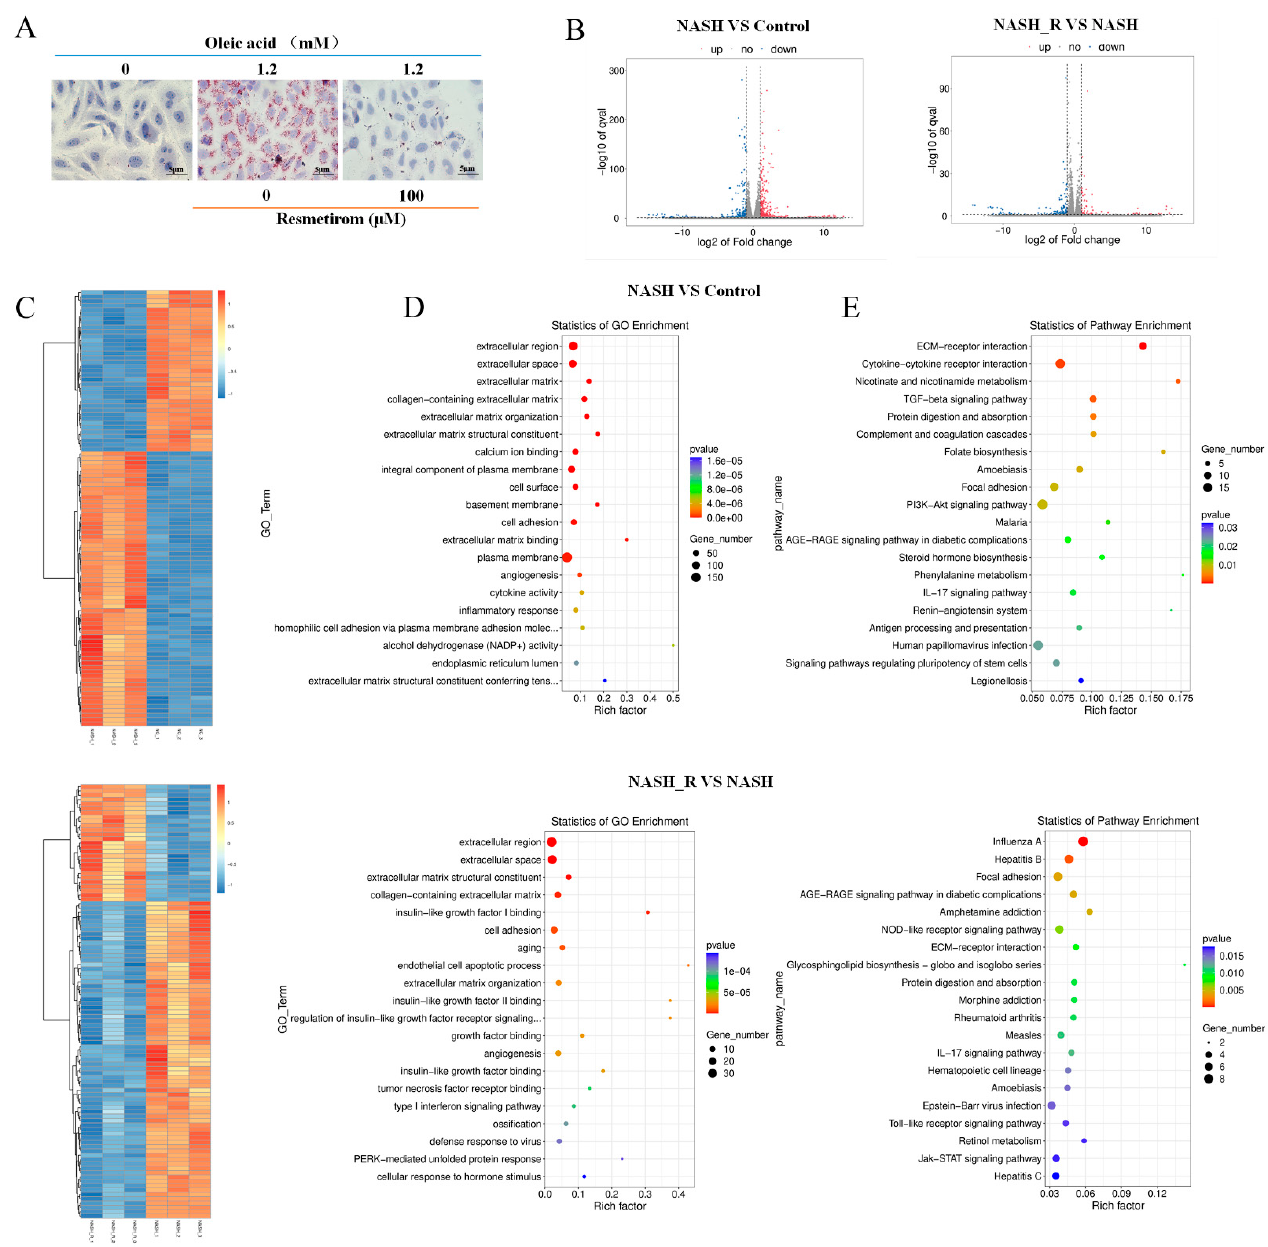
Figure 2. mRNA sequencing was performed to elucidate the mRNA expression profile in the resmetirom-treated NASH cell model. ( A ), HepG2 cells were pre-incubated with 0 or 100 μ M resmetirom for 48 h, followed by treatment with 0- or 1.2-mM oleic acid for another 48 h, and Oil red O staining experiment was performed to determine the intervention effect of the drug. ( B ), Total RNA was extracted for mRNA-sequencing assay, differentially expressed genes (DEGs, fold change > 2, p < 0.05) were obtained, and volcano plots were generated using DEGs between NASH (NASH cell model) vs. control (left panel), and NASH_R (NASH cell model treated with 100 μ M resmetirom) vs. NASH (right panel). ( C ), Heat maps were produced for DEGs between NASH vs. control (upper panel), and NASH_R vs. NASH (lower panel). ( D ), GO enrichment analysis was performed in DEGs between NASH vs. control (upper panel), and NASH_R vs. NASH (lower panel). ( E ), KEGG enrichment analysis was performed in DEGs between NASH vs. control (upper panel), and NASH_R vs. NASH (lower panel). 2.3. Resmetirom Might Ameliorate NAFLD/NASH in an RGS5-Dependent Manner